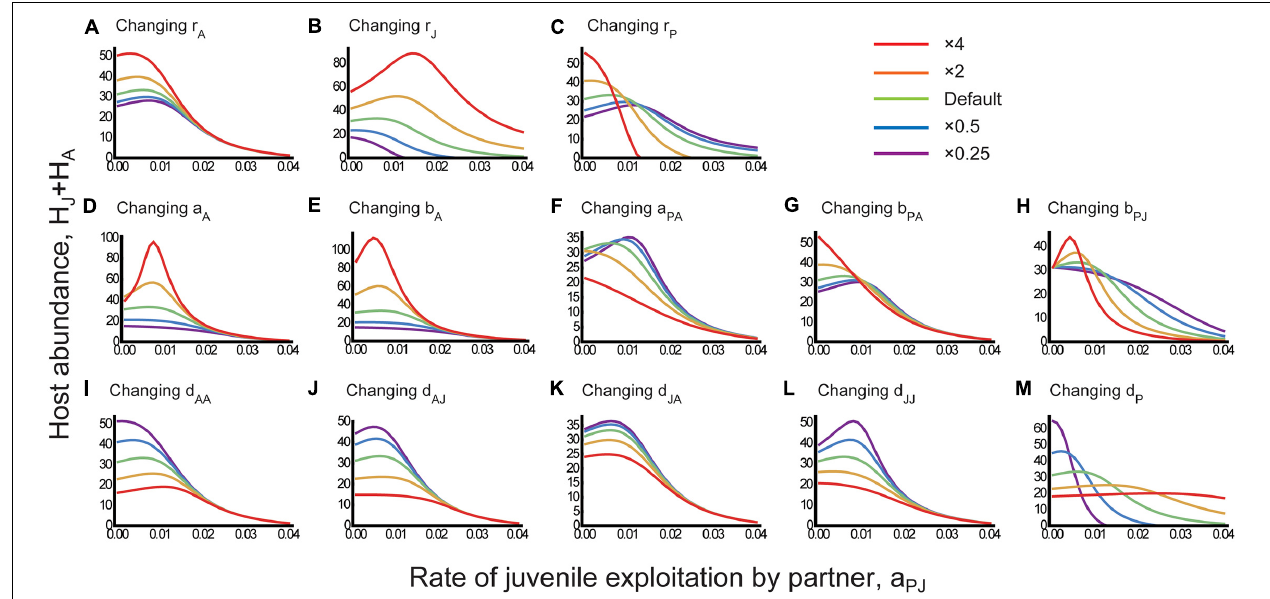
FIGURE 3 | Parameter effects on the consequences of juvenile-specific parasitism for host abundance. The total host abundance H J + H A is plotted against the rate of juvenile exploitation by the partner species a PJ for different parameter sets. One parameter is manipulated in each panel: (A) r A , (B) r J , (C) r P , (D) a A , (E) b A , (F) a PA , (G) b PA , (H) b PJ , (I) d AA , (J) d AJ , (K) d JA , (L) d JJ , and (M) d P . Different line colors indicate the magnitude of parameter manipulation in comparison with the default value, as indicated in the top right-hand corner. The default parameters were r i = r P = 1, a A = 0.02, a PA = 0.01, b A = b Pi = 5, d ii = d P = 0.05, d JA = 0.01, and d AJ =